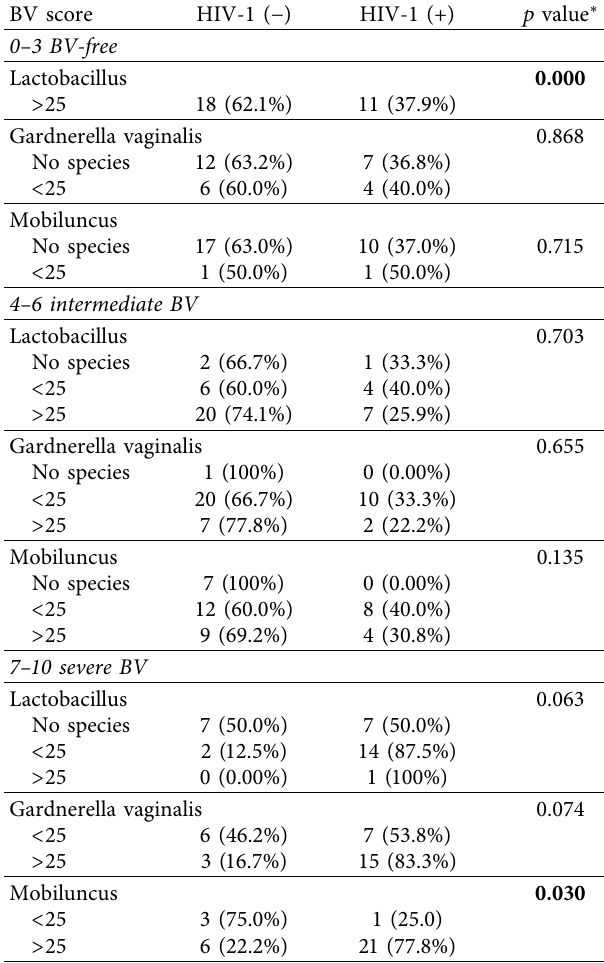
Table 3: Association of BV species and HIV